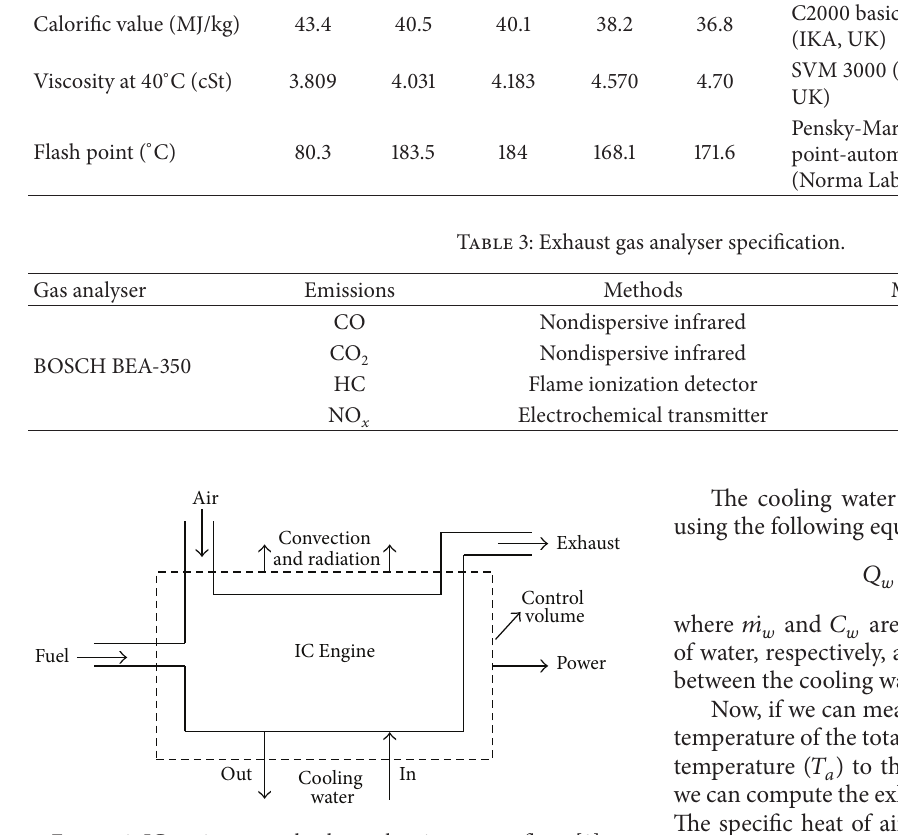
Figure 2: IC engine control volume showing energy flows